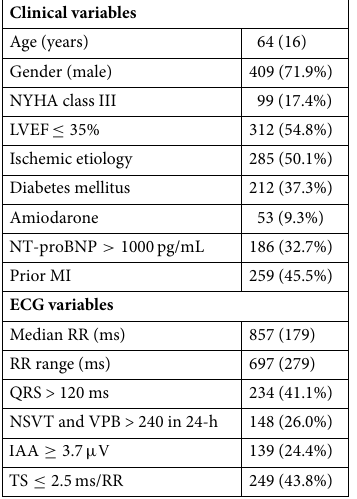
Table 1. Clinical and ECG variables of database. Data are represented as median (interquartile range) for continuous variables and as number (percentage) for dichotomized variables. IAA index of average alternans, LVEF left ventricular ejection fraction, NSVT nonsustained ventricular tachycardia, NYHA New York Heart Association, TS turbulence slope, VPB ventricular premature